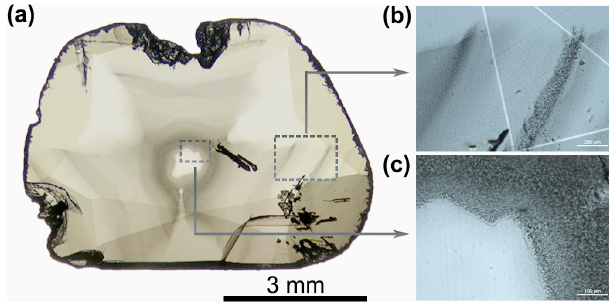
Figure 2. The distribution of graphite inclusions in Zimbabwean mixed-habit diamond (modified after Sun et al., 2022). (a) Color zoning of NDS-2 under mono-polarized light. (b) Parallel enriched bands of graphite inclusions in cuboid sectors. (c) Much smaller inclusions between octahedral sectors and cuboid sectors.